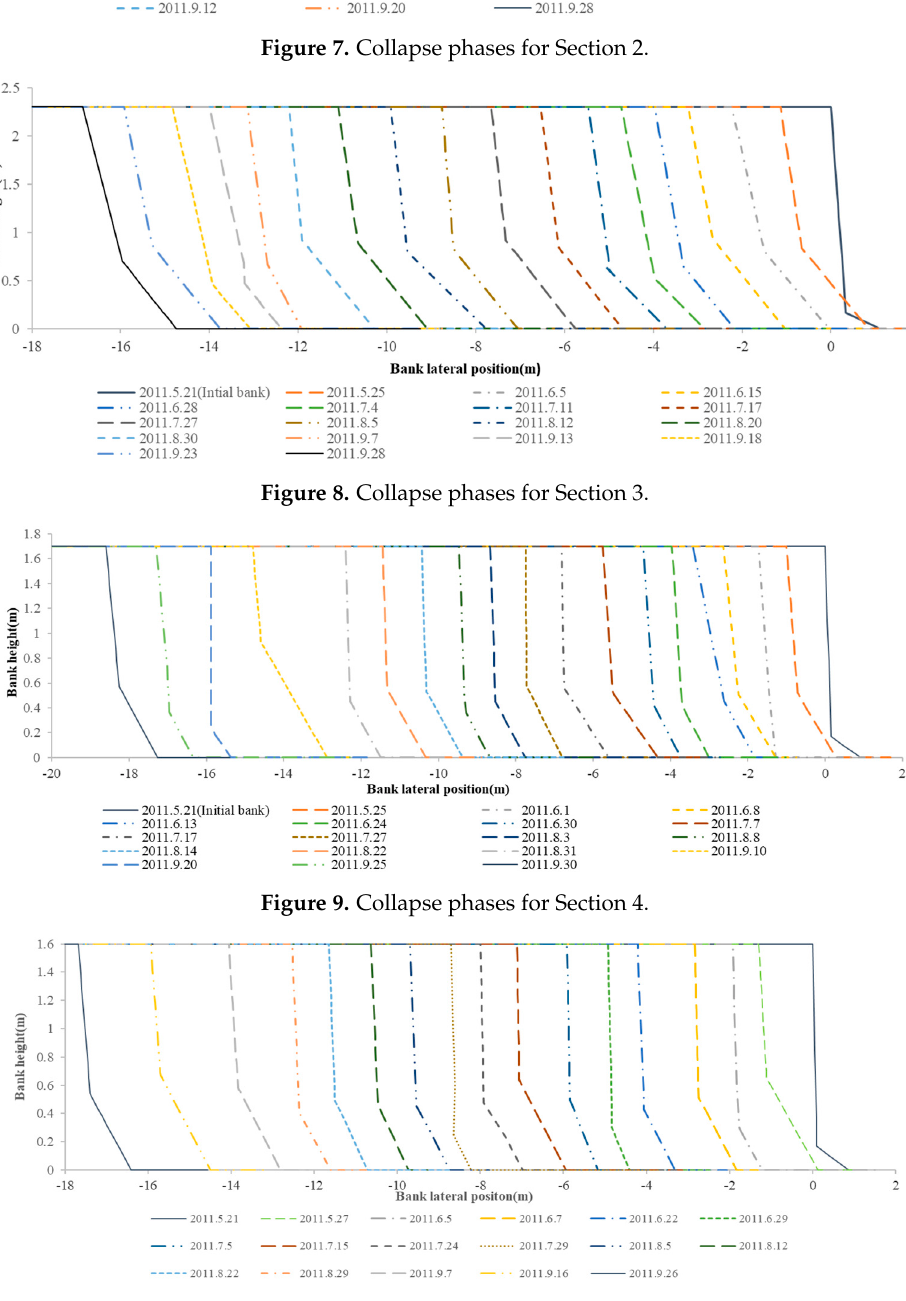
Figure 10. Collapse phases for Section 5.